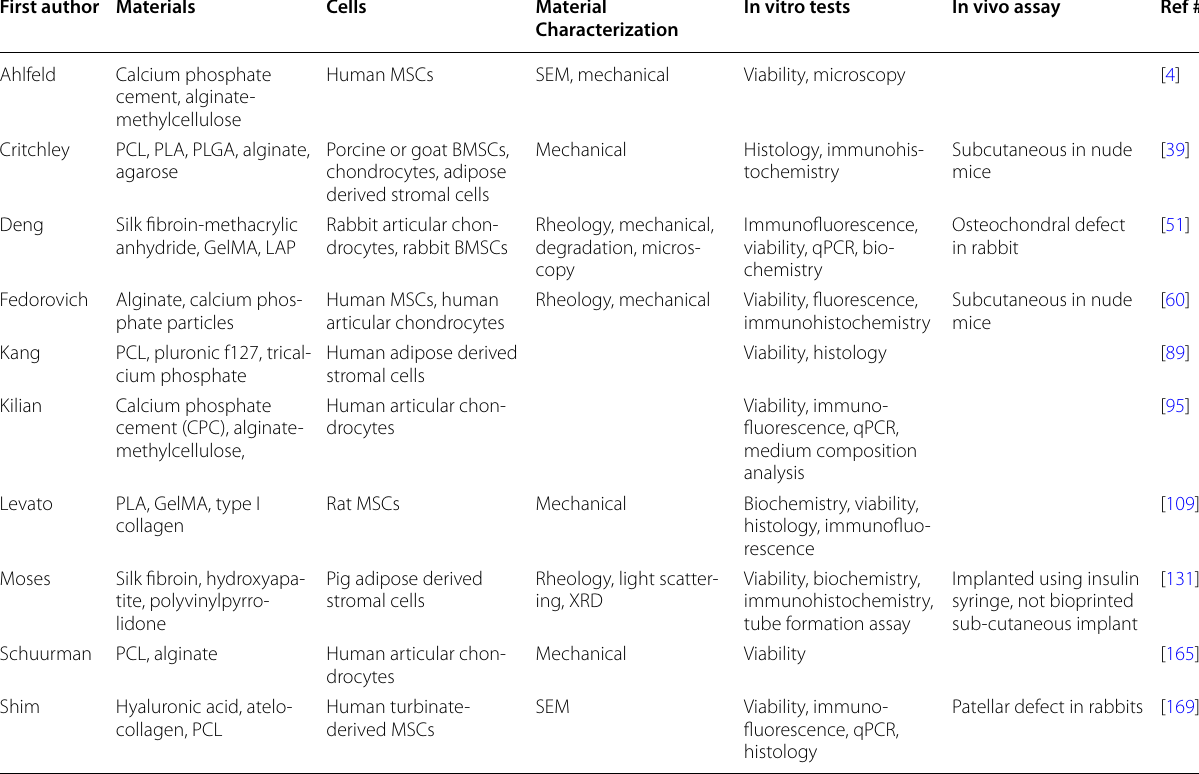
Table 4 Osteochondral 3D bioprinting: materials, cells and characterizations First author